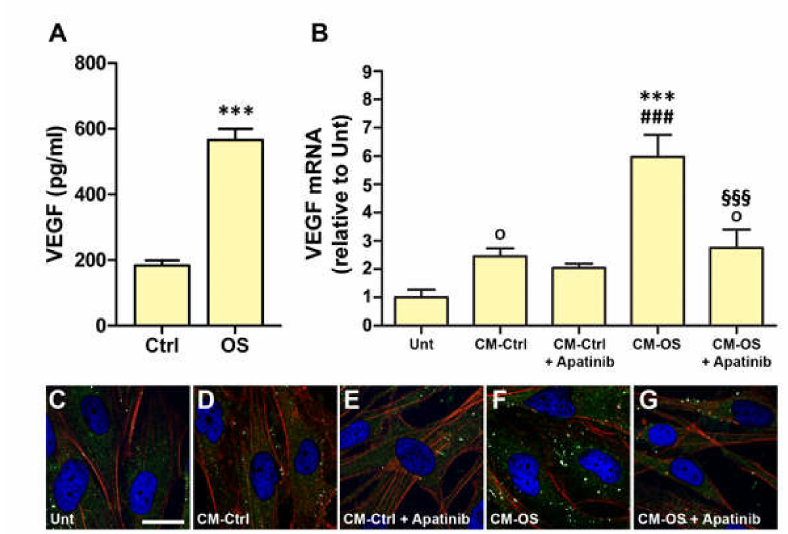
Figure 3. ( A ) VEGF release in the culture medium of MIO-M1 cells exposed to OS for 24 h, as measured with ELISA. ( B ) VEGF mRNA expression in MIO-M1 cells incubated for 24 h in the conditioned medium of untreated MIO-M1 cells (CM-Ctrl) or of MIO-M1 cells exposed to OS for 24 h (CM-OS), with or without the VEGFR2 blocker Apatinib at 0.1 µ M. *** p < 0.001 relative to control MIO-M1 cell cultures (Ctrl) ( A ) or to untreated MIO-M1 cell cultures (that is incubated in non-conditioned medium, Unt) ( B ), §§§ p < 0.001 relative to CM-OS, and ### p < 0.001 relative to CM-Ctrl as evaluated with